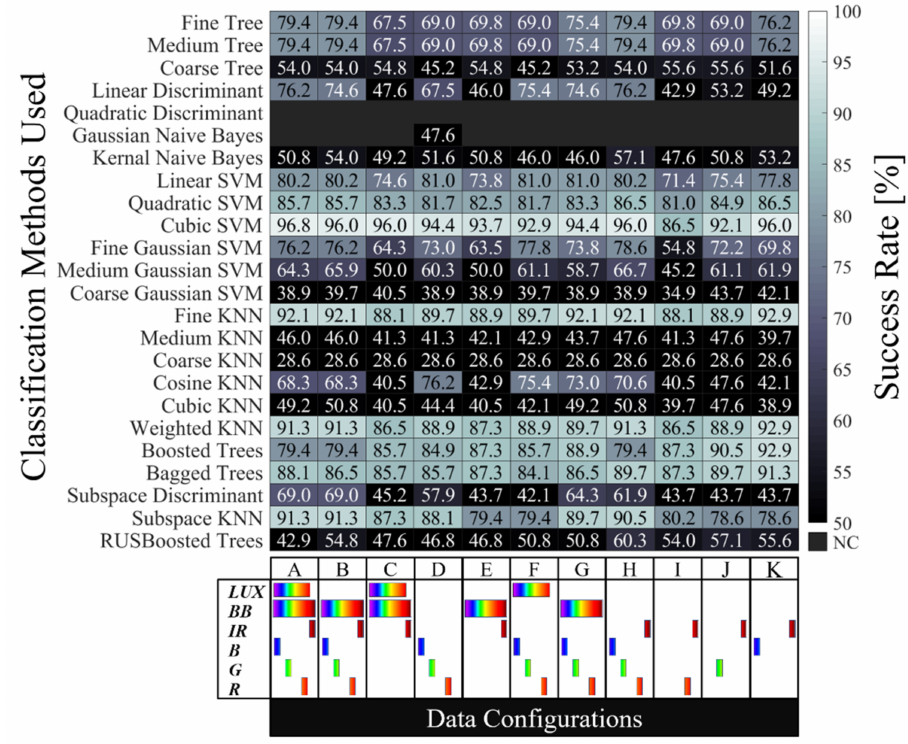
Figure 4. Results of training classifiers on the raw data set. The classification success varies drastically depending on the classification method used. The best results are achieved with Cubic SVM, Fine KNN and Weighted KNN. The choice of the data features configuration has a less significant impact on the training